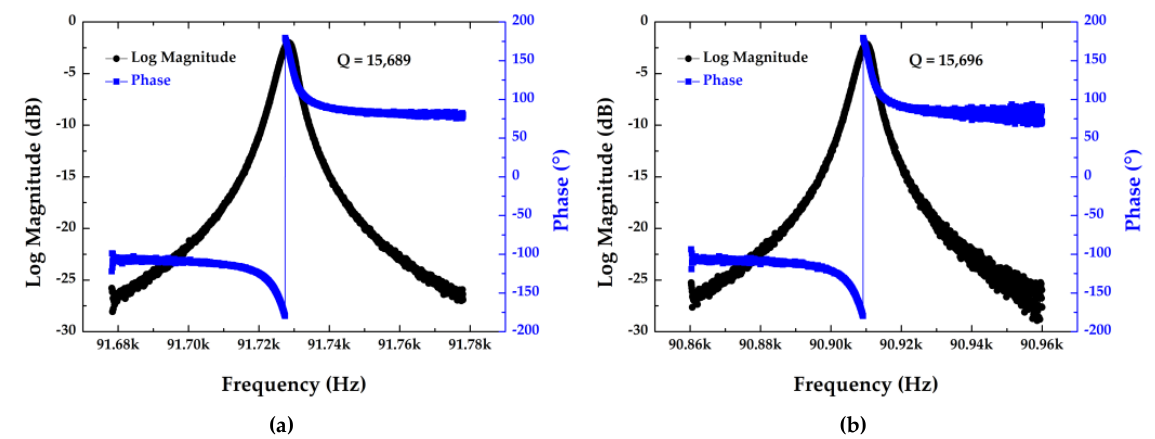
Figure 8. The properties of ( a ) resonator I and ( b ) resonator II under an atmospheric pressure of 100 kPa and a room temperature of 25 °C.